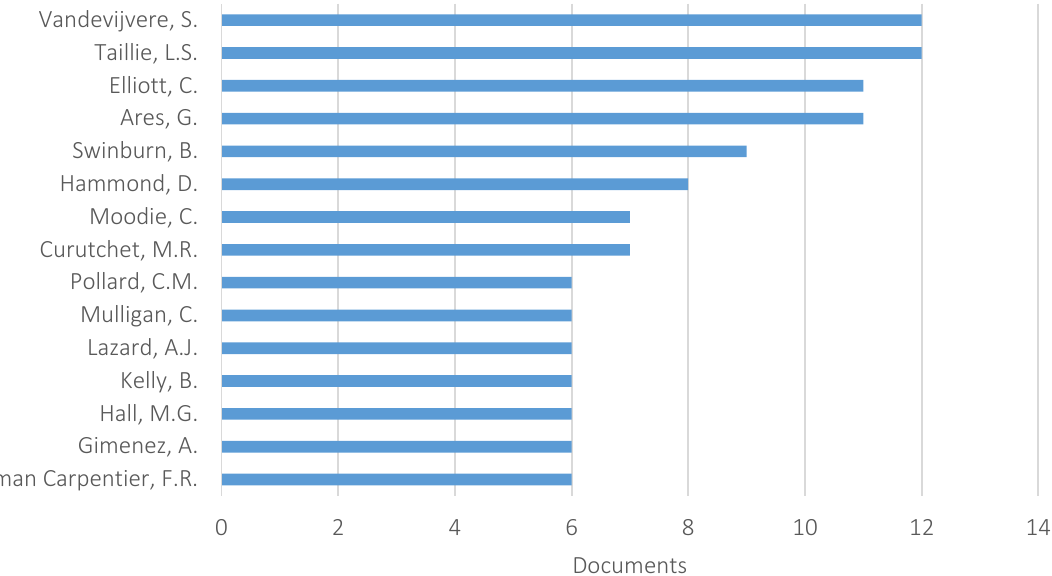
0 Figure 2. Top 15 most productive authors for the period 2017–2022